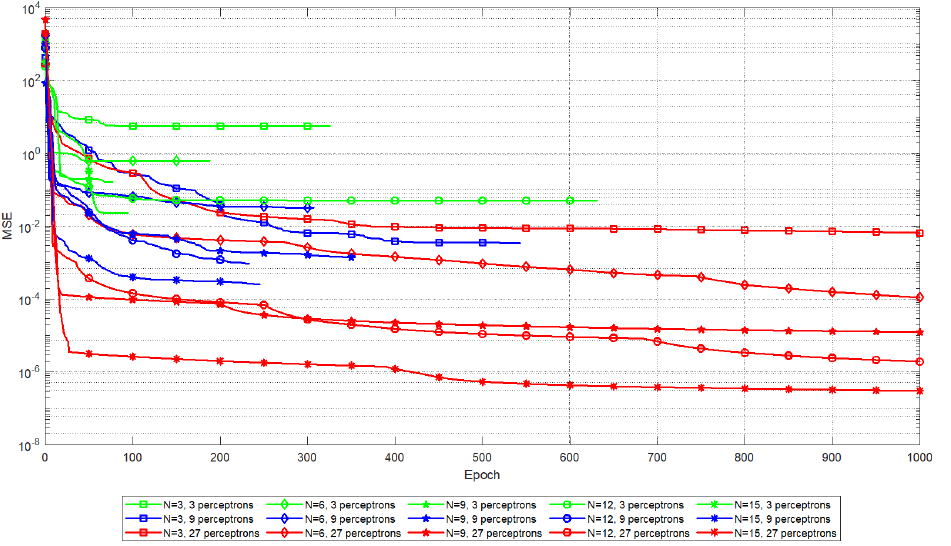
Figure 7. Training Performance considering 3, 9, and 27 perceptrons per layer, for N = 3,6,9,12, and 15 Sensors (MLP